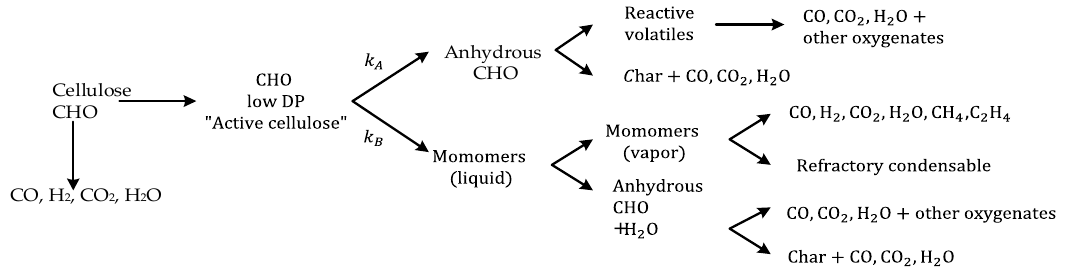
Figure 9. Schematic of cellulose pyrolysis (adapted from [76]).